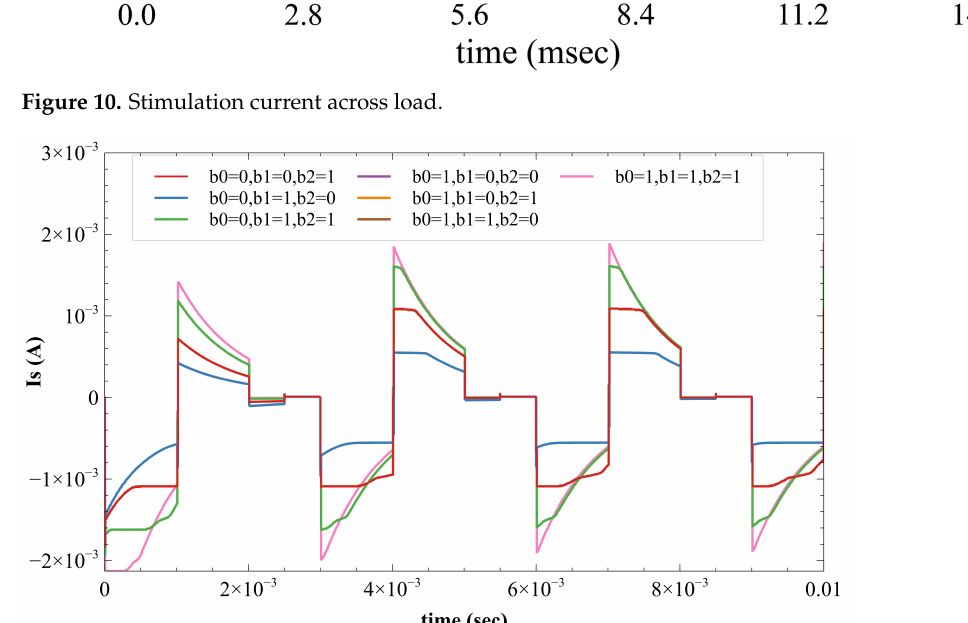
Figure 11. Different stimulation current with respective programmable bits.